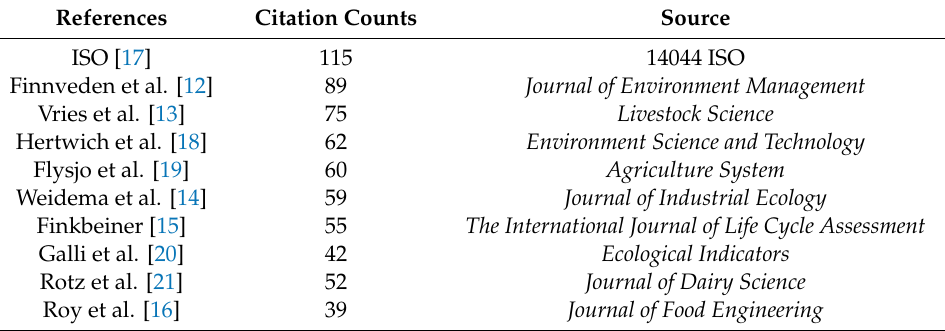
Table 2. Top 10 references based on cited frequency.